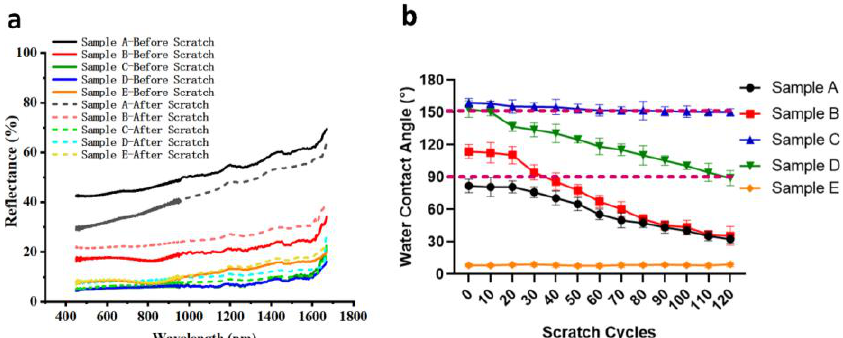
Figure 7. ( a ) The spectral reflectance of samples A–E before and after 120 scratch cycles; ( b ) the variation of water contact angle on samples A–E as a function of scratch cycles during the scratch tests.